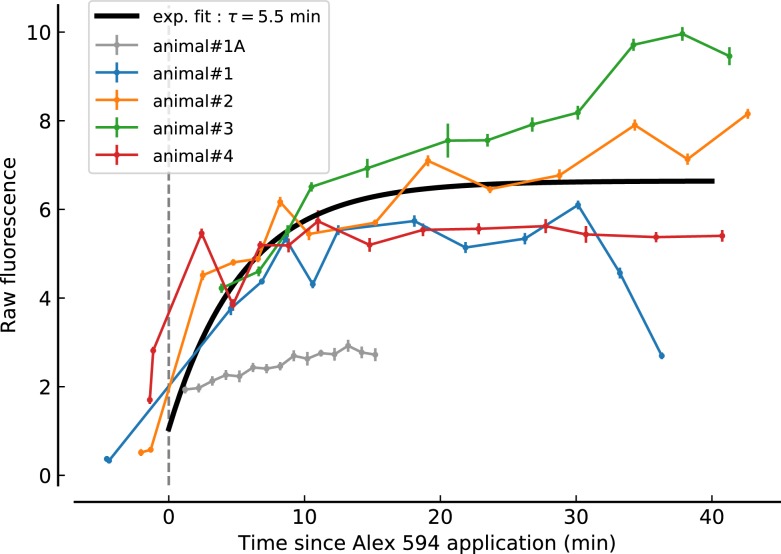
Summary of Alexa 594 fluorescence changes related to drug application for all animals.Raw Alexa 594 fluorescence is shown as function of time since application at t = 0 min. 50 μM Alexa was added to the drug-containing ACSF to assess the dynamics of drug diffusion in the recorded brain area. Each animal is depicted by a different color. Note that the recording of animal#1A was excluded from the analysis due to the inefficiency of drug application in the area of interest as reported by in impaired increases in Alexa fluorescence (gray points and line). A single exponentially increasing function (black line) was fitted to the data for t > 0 and starting at the average pre-application fluorescence average across all animals. Each recording point comprises 100 images recorded at 30 Hz of a 400 × 400 μm field of view and pixel size of 0.78 × 0.78 μm. Data-points display average and standard deviation of the image stack fluorescence values.